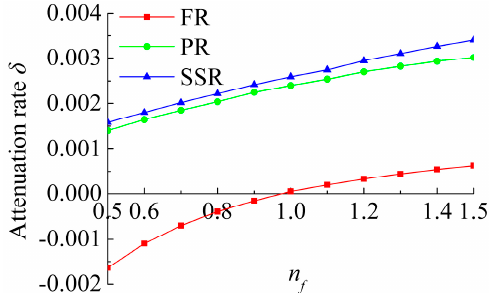
Figure 13. Effect of sectional area of surge tank on attenuation rate of unit frequency under FR, PR and SSR [66].